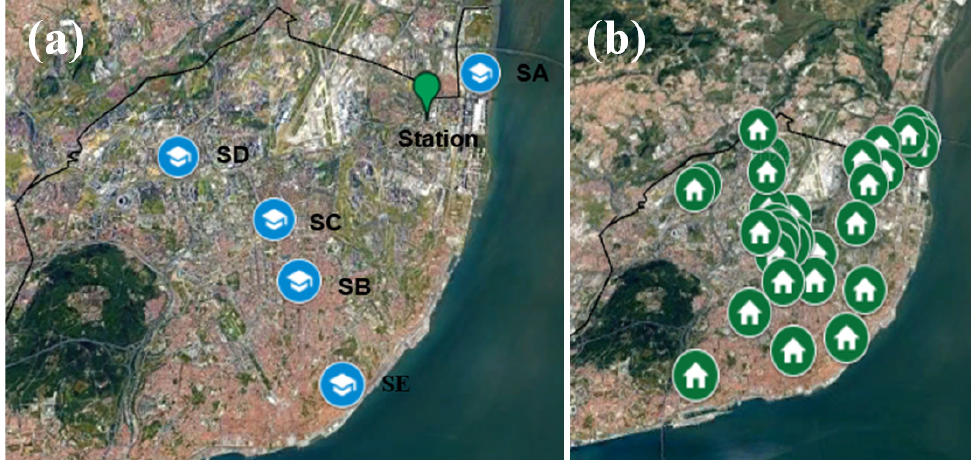
Figure 1. ( a ) Locations of the schools and fixed monitoring station and ( b ) location of